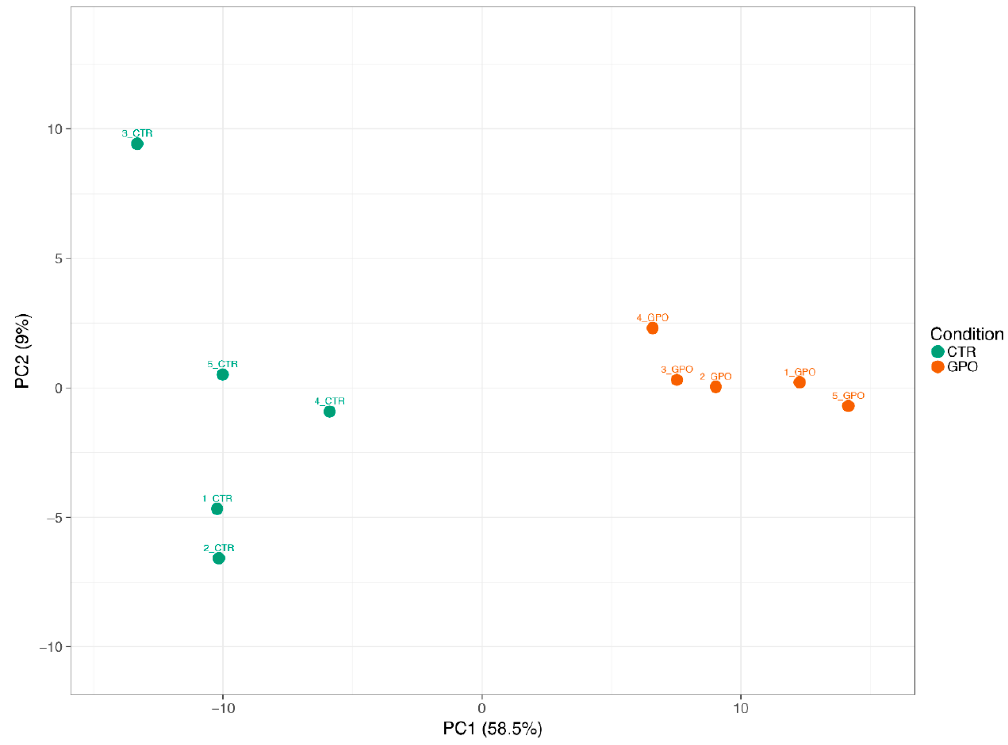
Figure 3. Principal component analysis (PCA) plot of the differentially expressed genes (DEGs) in veal calves after 75-days of grape pomace (GPO) supplementation, compared with unsupplemented control group (CTR). The GPO-supplemented animals (orange circles, right side) are separated from the unsupplemented CTR animals (green circles, left side) with the first two components (PCA1 and PCA2) accounting for 69% of the total variation. The PCA plots were created using the Clustvis tool (https://biit.cs.ut.ee/clustvis/) by [21]. For interpretation of the references to color in this figure legend, the reader is referred to the web version of this article.